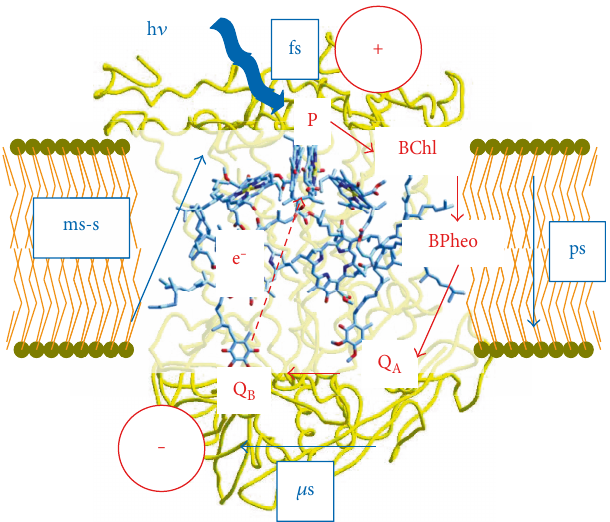
Figure 5: Schematic representation of the arrangement of RC cofactors and the charge stabilization routes in the photosynthetic membrane. Solid and dashed arrows indicate the forward charge separation and the backward charge recombination routes, respectively. P: primary electron donor; BChl: bacteriochlorophyll; BPheo: bacteriopheophytin; Q : primary quinone type electron A acceptor; Q : secondary quinone type electron acceptor. The time B intervals in which the appropriate processes occur are also indicated in blue boxes.